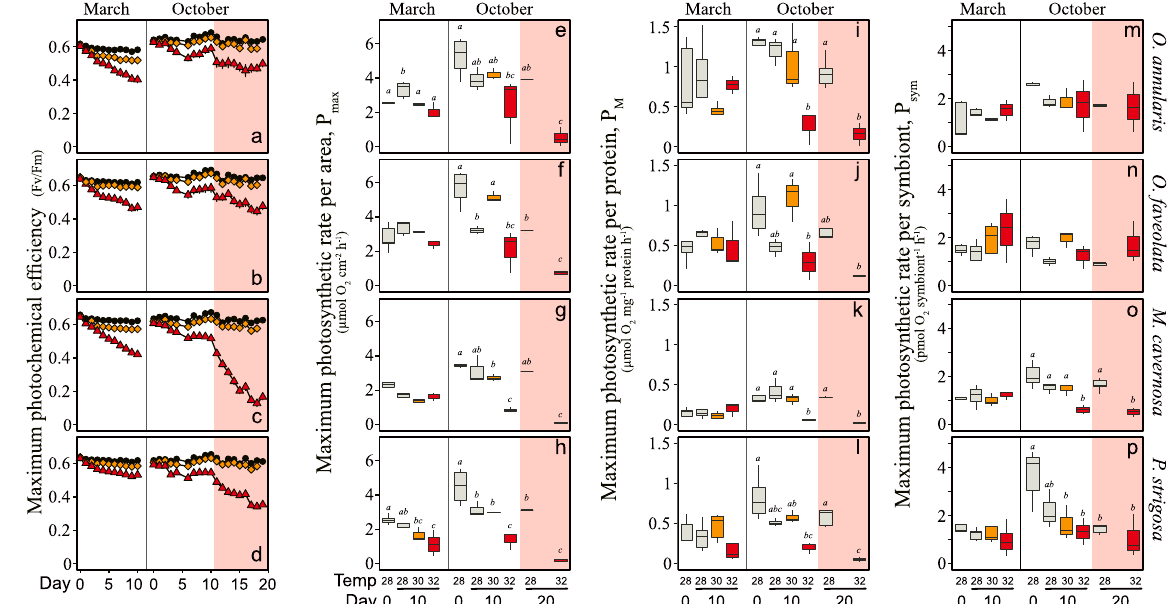
Figure 6. Response of coral photosynthesis to heat-stress. ( a – d ) Daily averages for F v /F m recorded at dusk (n > 10) for corals exposed to control (28 °C, black triangles), 30 °C (orange triangles) and 32 °C (red triangles) in March (winter phenotype) and October (summer phenotype). ( e–p ) Box plots describing the variability of the photosynthetic responses of the four coral species investigated: Orbicella annularis , Orbicella faveolata , Montastraea cavernosa , and Pseudodiploria strigosa . Each plot describes coral responses in March (winter phenotype) and October (summer phenotype), after 10 days (white area) and 20 days (red area) of exposure to control (28 °C; grey), 30 °C (orange), and 32 °C (red). Boxes encompass the 25 and 75% quartiles of all the data (n = 5). The central line corresponds to the median, and bars extend to the 95% and 5% of the confidence limits. Letters mark the significant differences (Tukey Post-Hoc test, p < 0.05) between treatments within a